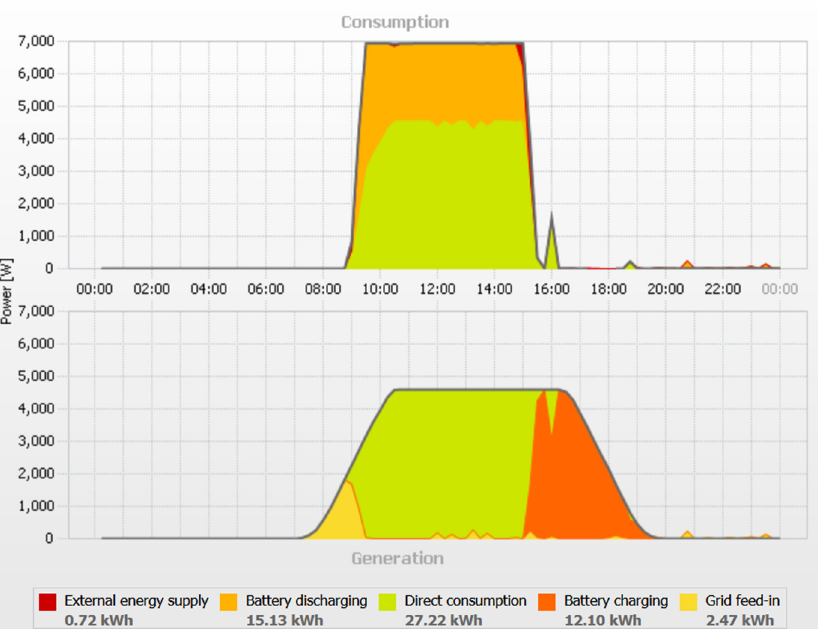
Figure 9. Above: EV Charging power: orange for the storage battery contribution, green for the RES contribution; below: RES generation limited by the grid single-phase unbalanced regulation.